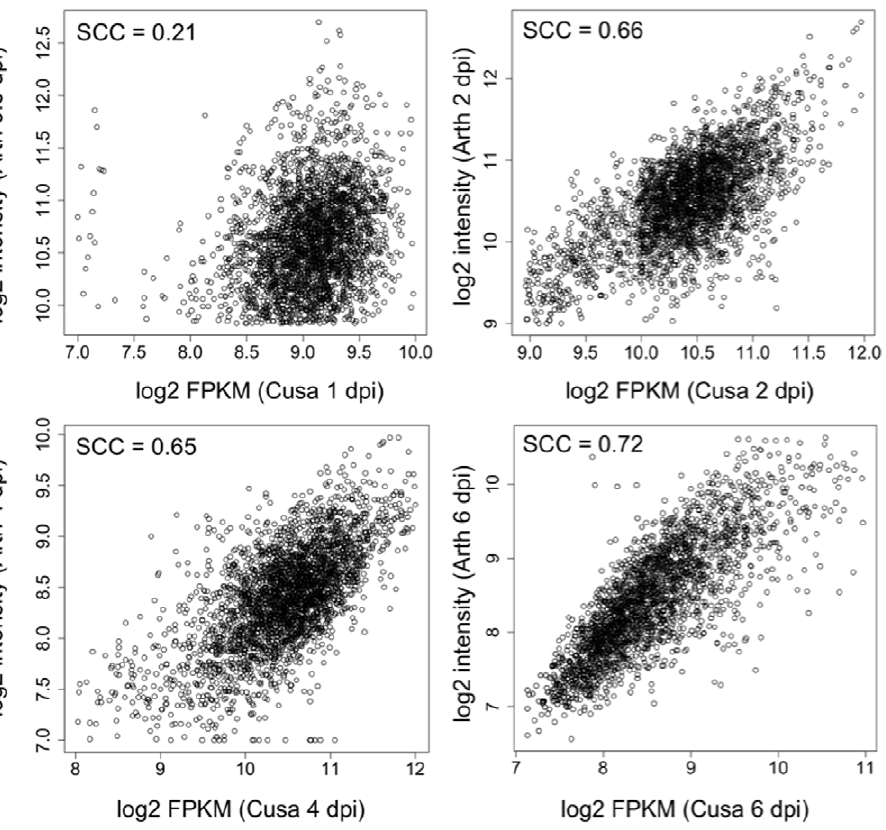
Figure 5. Comparison of orthologous gene expression in Cucumissativus and Arabidopsisthaliana in a compatible interaction. Microarray expression profiles were obtained from time-course analyses of genes expressed in A. thaliana (Arth) during infection by H. arabidopsidis [41]. Single copy orthologous genes between C. sativus (Cusa) and A. thaliana were identified using OrthoMCL [63]. Log2 transformed expression values of single copy orthologous genes expressed in the C. sativus mRNA-Seq dataset (log2 fragments per kilobase pair of exon model per million fragments mapped [FPKM]) and A. thaliana microarray dataset (log2 intensity) are shown as scatter plots. SCC, Spearman correlation coefficient; dpi, days post-inoculation.